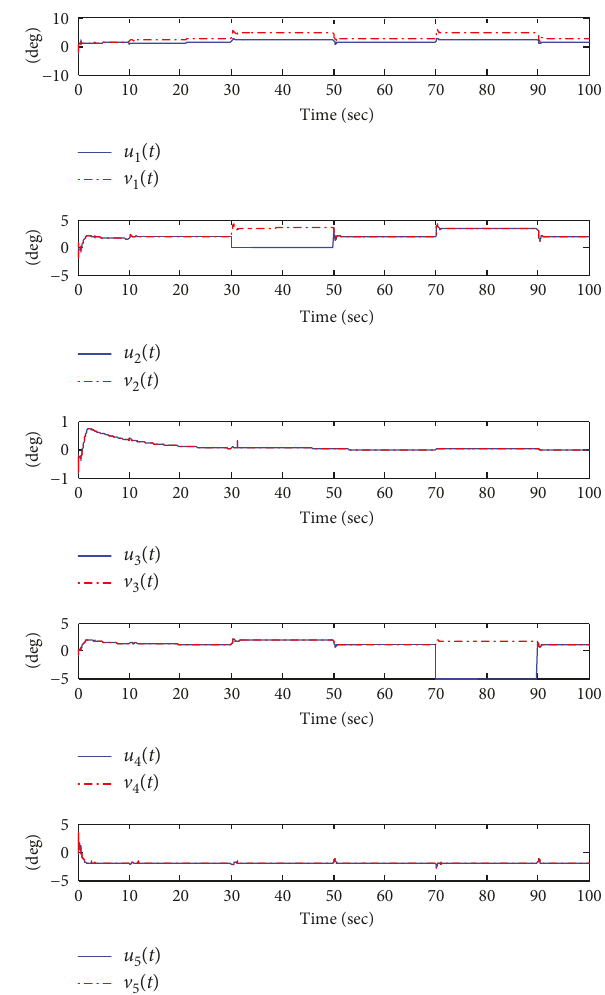
Figure 3: Actual control signal u ( t ) and designed control signal v ( t ) of controller